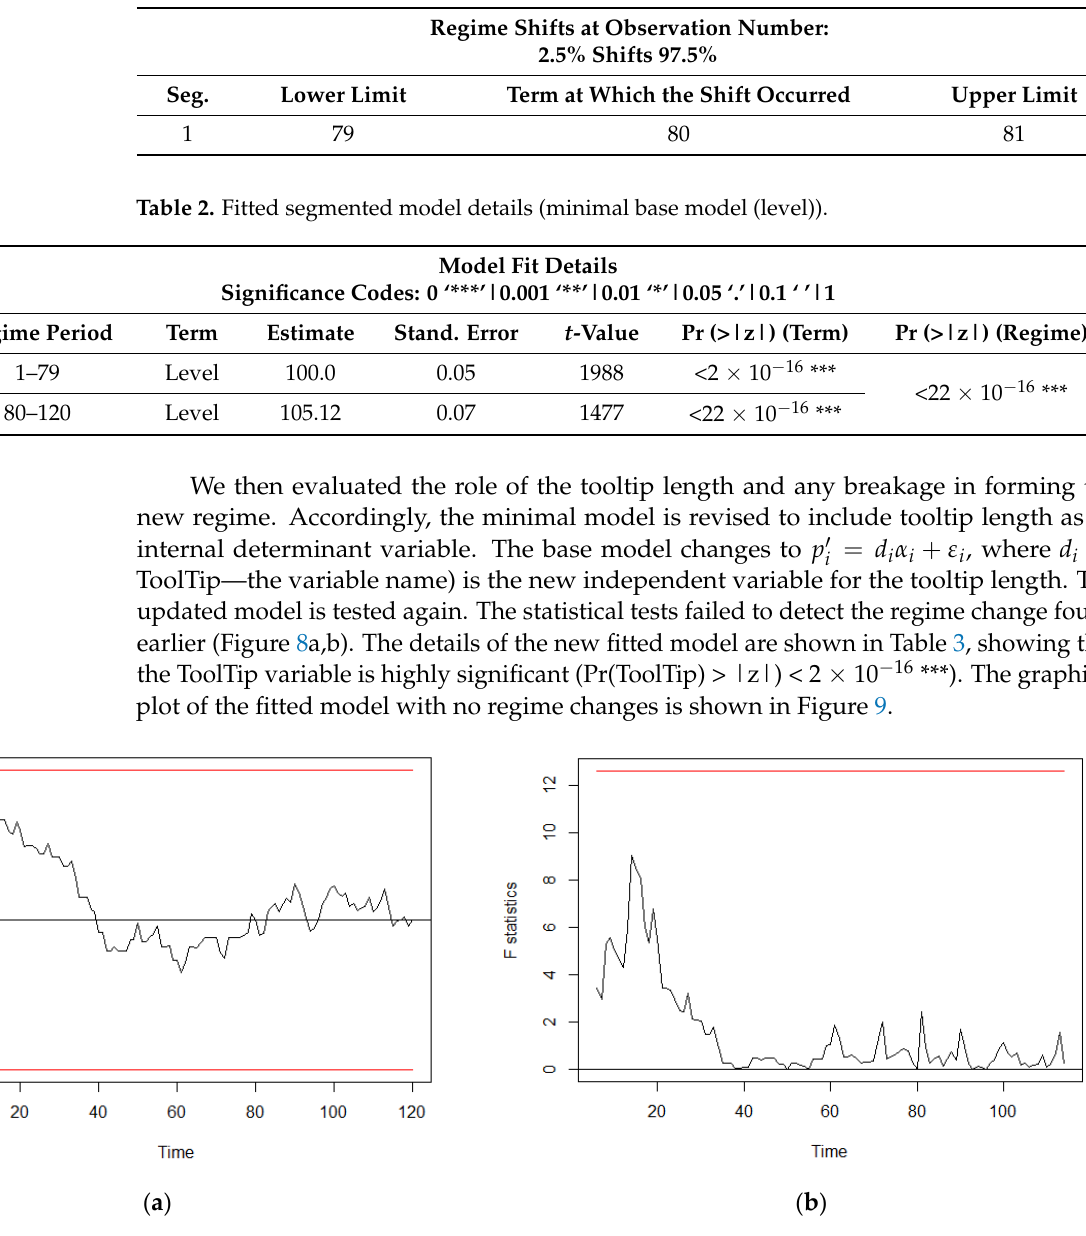
Figure 8. Statistical test results (updated base model). ( a ) Empirical Fluctuation ( b ) F-Statistics. Table 3. Fitted Model details (Updated base model).